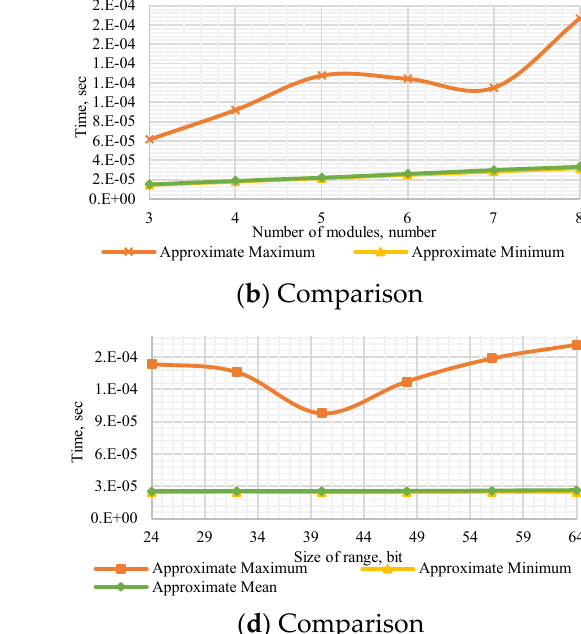
of modules (cid:1868) , ( b ) compare dynamic number of modules (cid:1868) , ( c ) determine the number’s sign with a